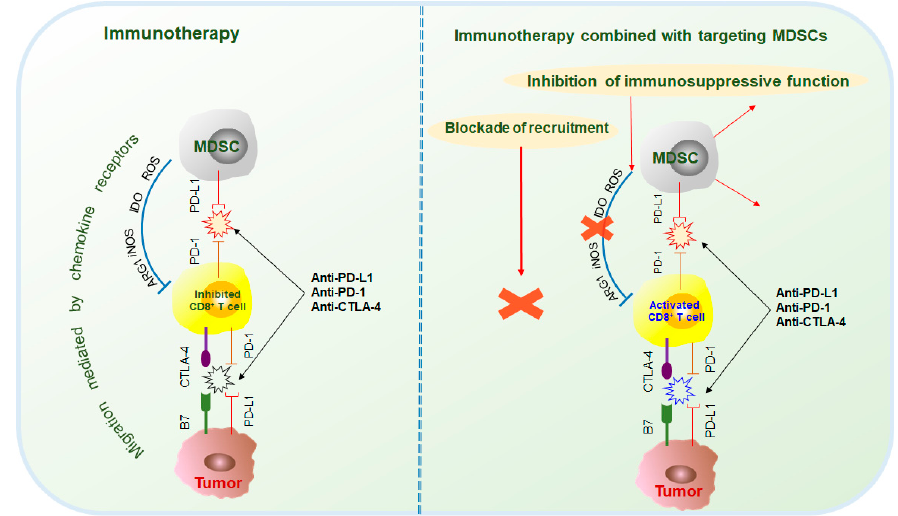
Figure 4. Combination of immunotherapy and targeting MDSCs. Using an immunotherapy